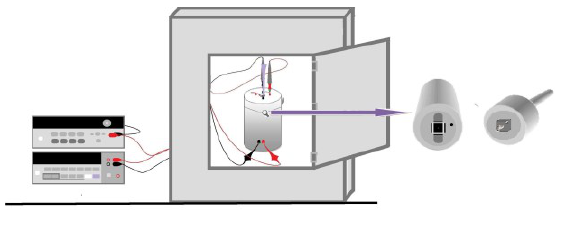
Figure 1. Microcalorimeter for the determination of immersion enthalpies.